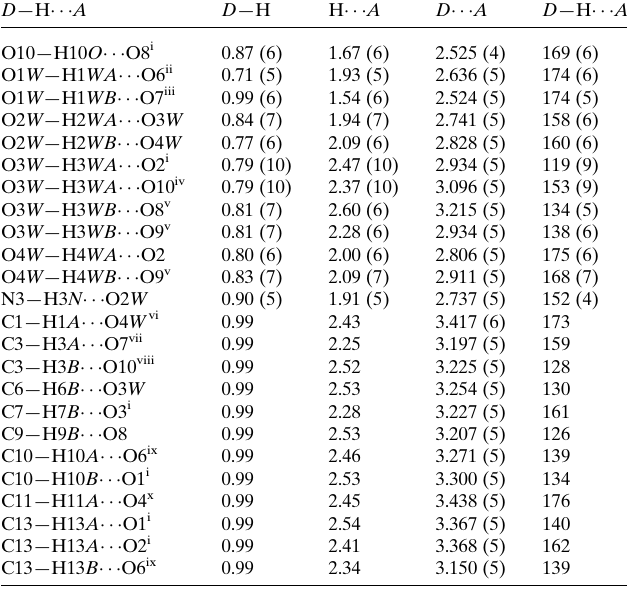
Table 1 Hydrogen-bond geometry (A˚ , (cid:3)